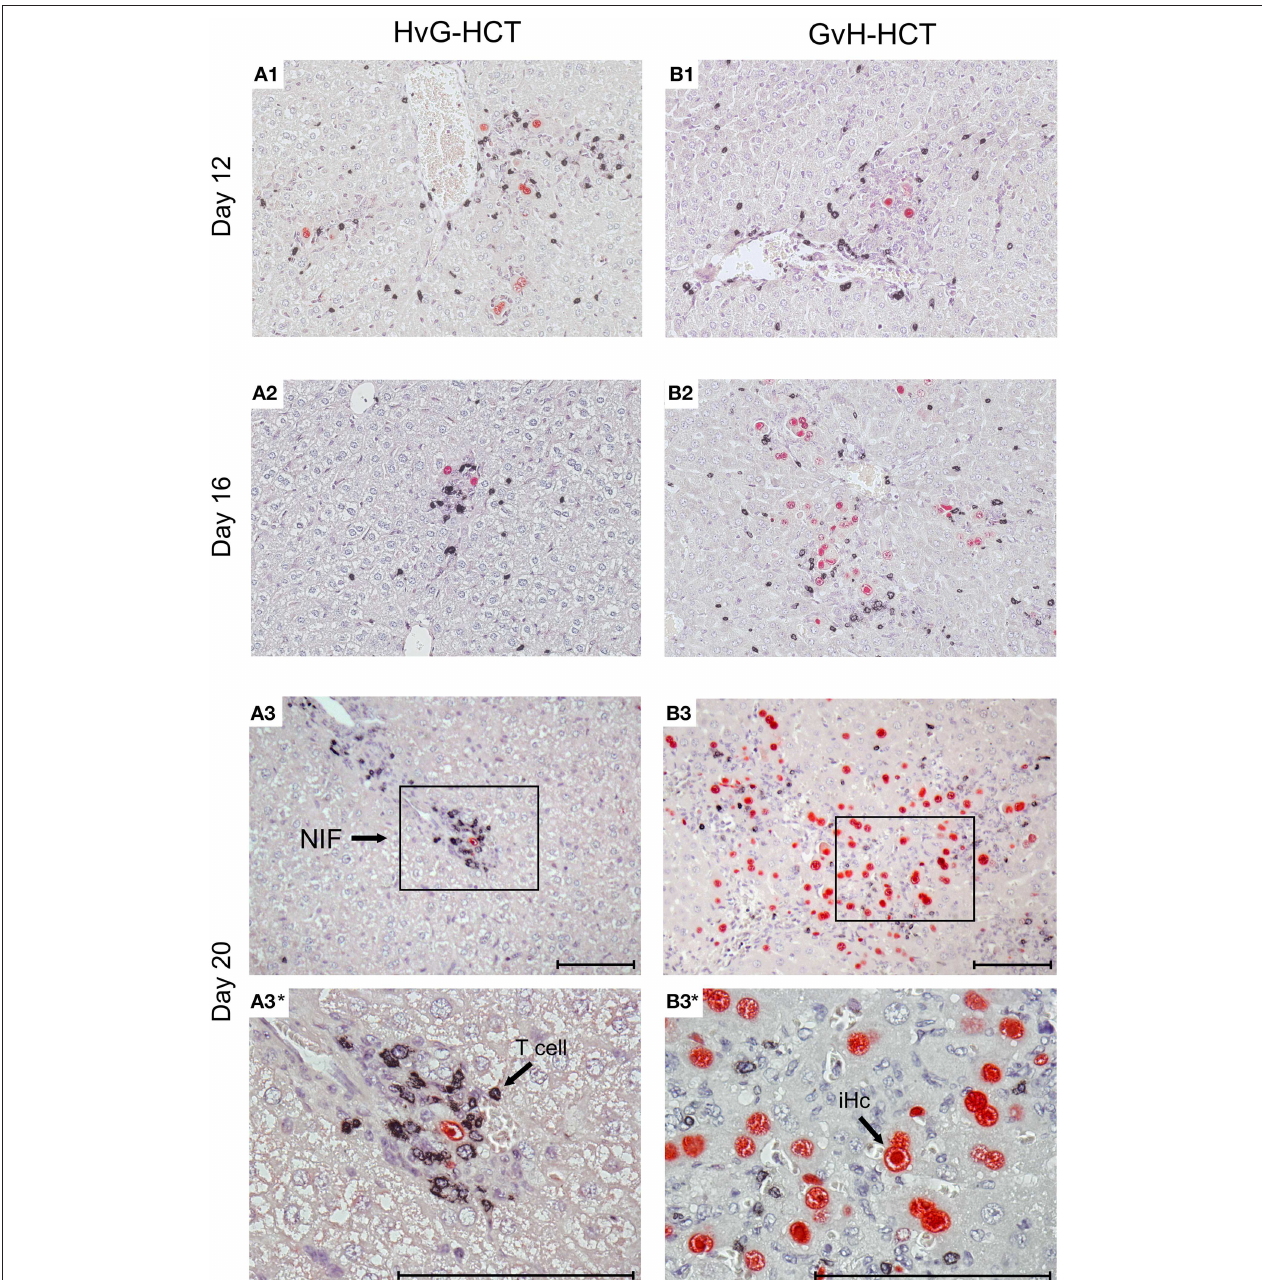
FIGURE 5 | Immunohistological images of liver tissue infection and infiltration by NIF-forming T cells after HvG-HCT compared to GvH-HCT. Representative 2C-IHC images of liver tissue sections are shown corresponding to the quantitative data shown in Figure 4 for the asterisk-marked observation times. (Red IHC staining) IE1 protein in nuclei of infected liver cells. (Black IHC staining) CD3 ε protein expressed by T cells. (Left column) HvG-HCT. (Right column) GvH-HCT. (A1–A3 and B1–B3) low magnification overview images. Frames in day-20 images A3 and B3 demarcate regions resolved to greater detail by higher magnification in images A3* and B3*, respectively. NIF, nodular inflammatory focus. T cells in images A3 and A3* cluster around an infected cell to form a NIF that confines the infection after HvG-HCT. Note the disseminated infection and scattered T-cell infiltrates in images B3 and B3* for GvH-HCT. iHc, infected hepatocyte with a typical intranuclear inclusion body that indicates the late phase of the productive viral cycle. Bar markers: 100 µ m.